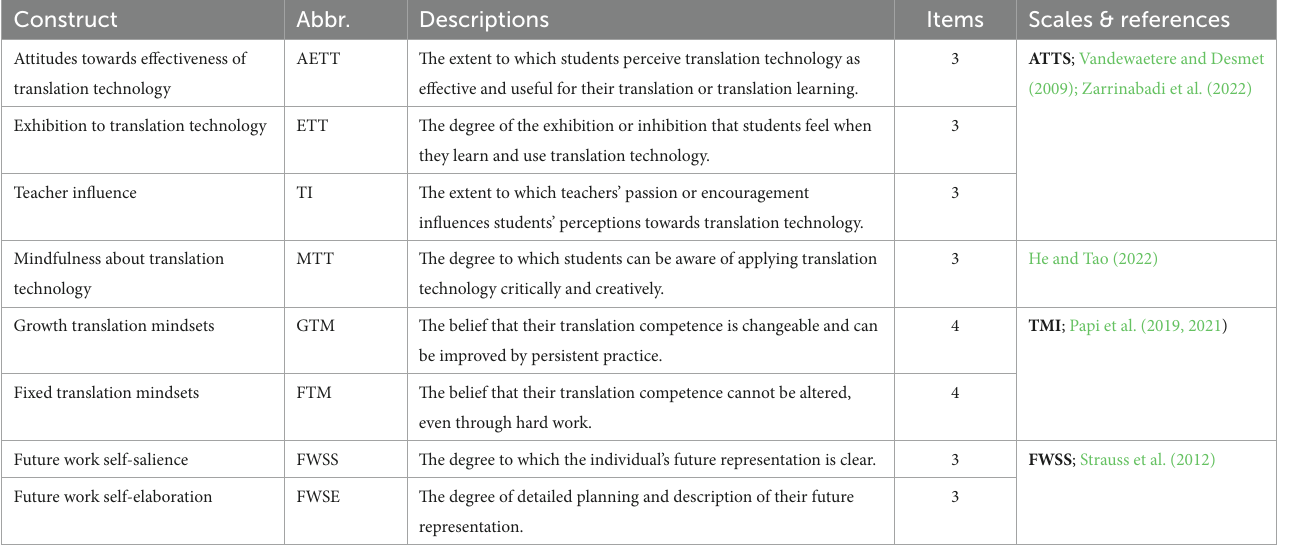
TABLE 4 List of the scales and measurement constructs. Construct